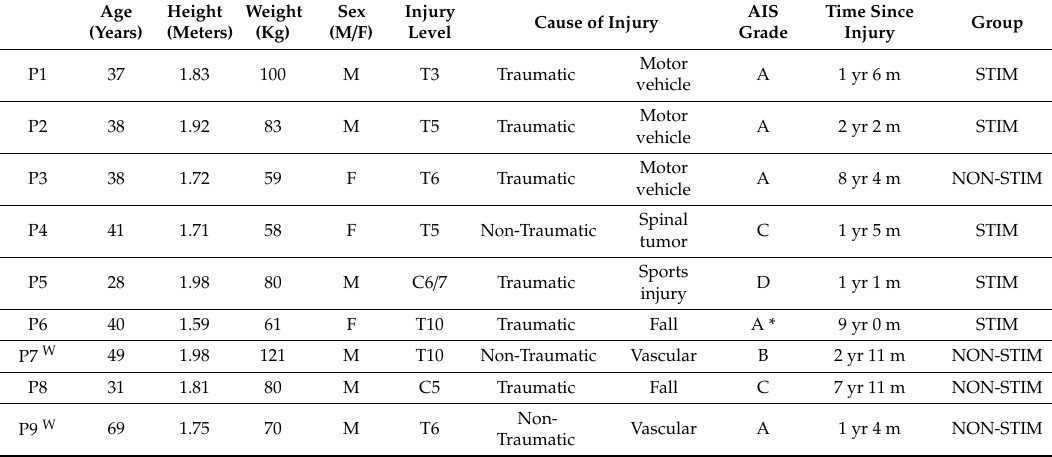
Table 1. Participant demographic